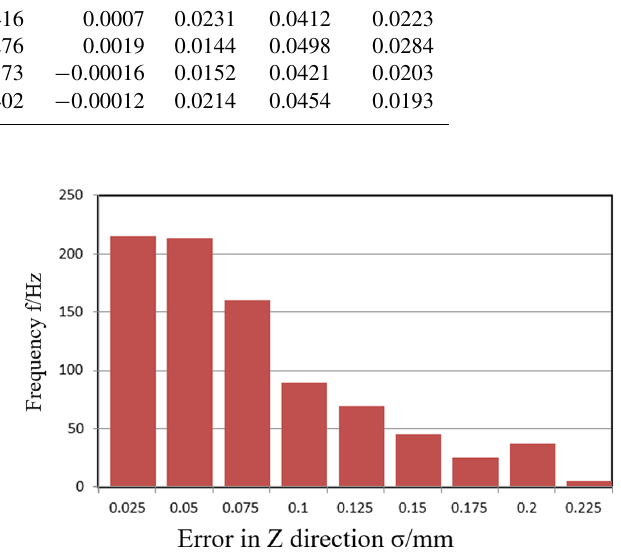
Figure 3. Frequency histogram of position error on working point in (0, 0, 1000) by matrix method.